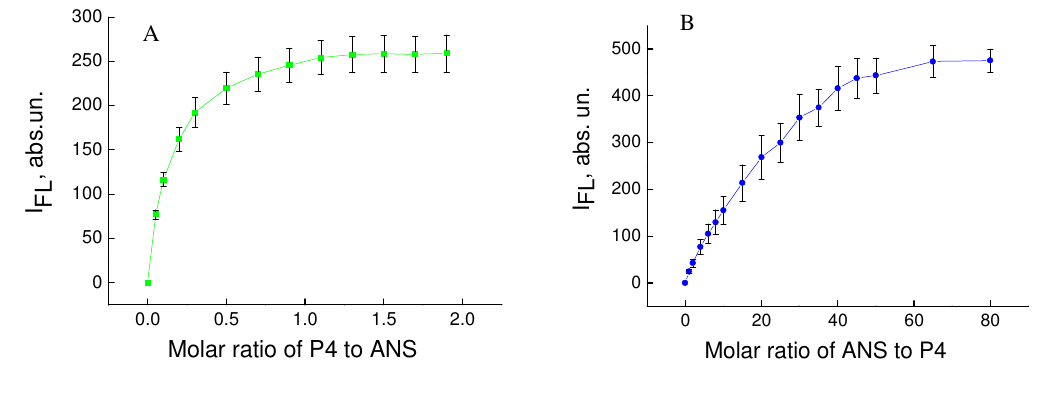
Figure 1. The first (a) and second (b) fluorimetric titration curves of 8-anilino-1- naphthalenesulfonate (ANS) and P4. (a) : constant concentration of ANS equal to 4 µ M. (b) : constant concentration of P4 equal to 0.5 µ M.